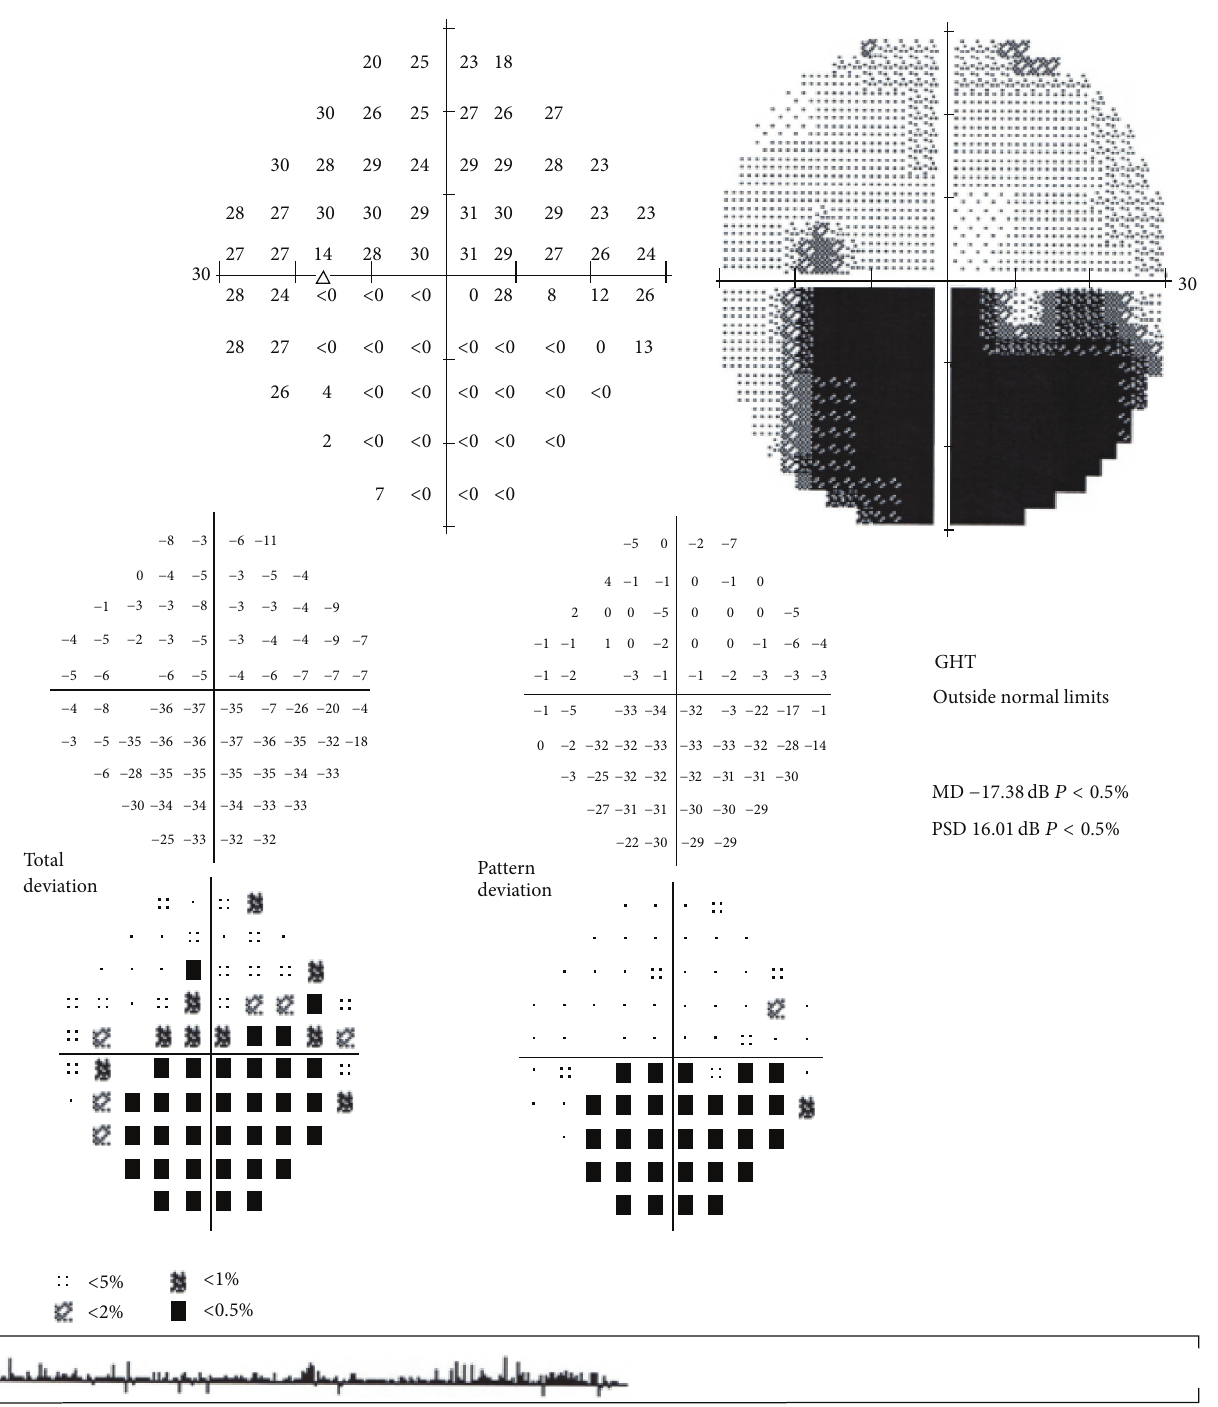
Figure 2: Corresponding visual field defect in the lower